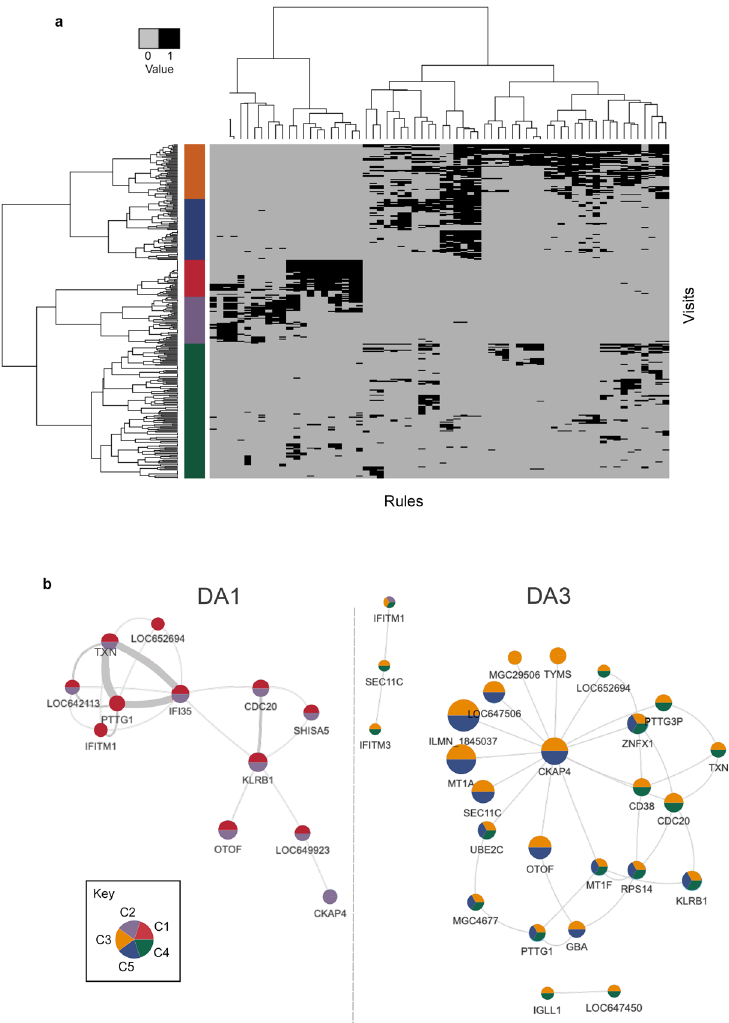
Figure 3. Hierarchical clustering of the model rules showed the major subdivision between the DA clusters. ( a ) Supported rules (black) and unsupported rules (grey) distinguish five disease subgroups that were projected into the ( b ) RN where group (cluster) membership is indicated by pie